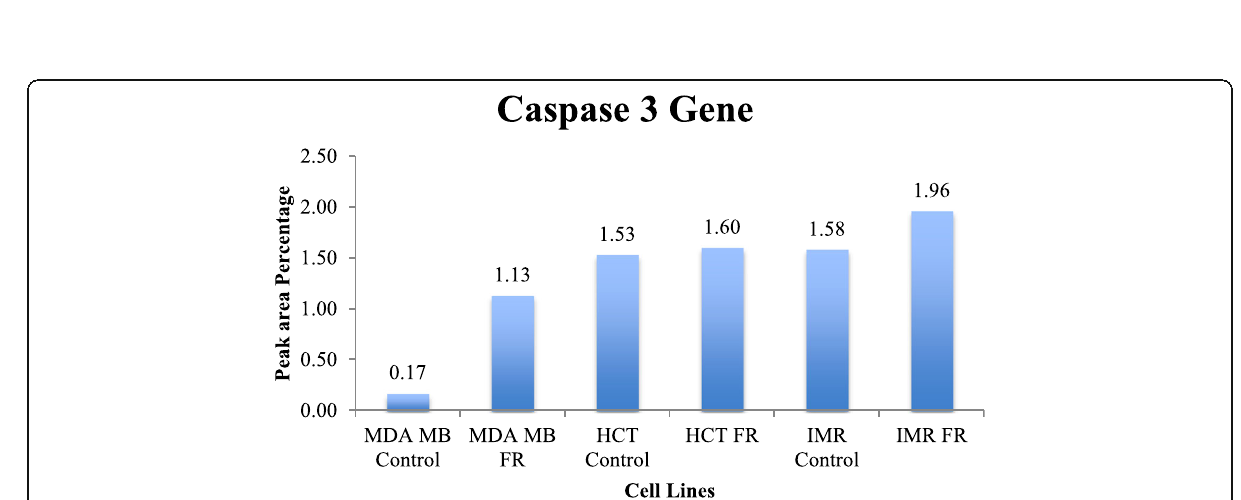
Fig. 10 The relative gene expression of Caspase-3 gene in all the cell lines. FR — Ficus